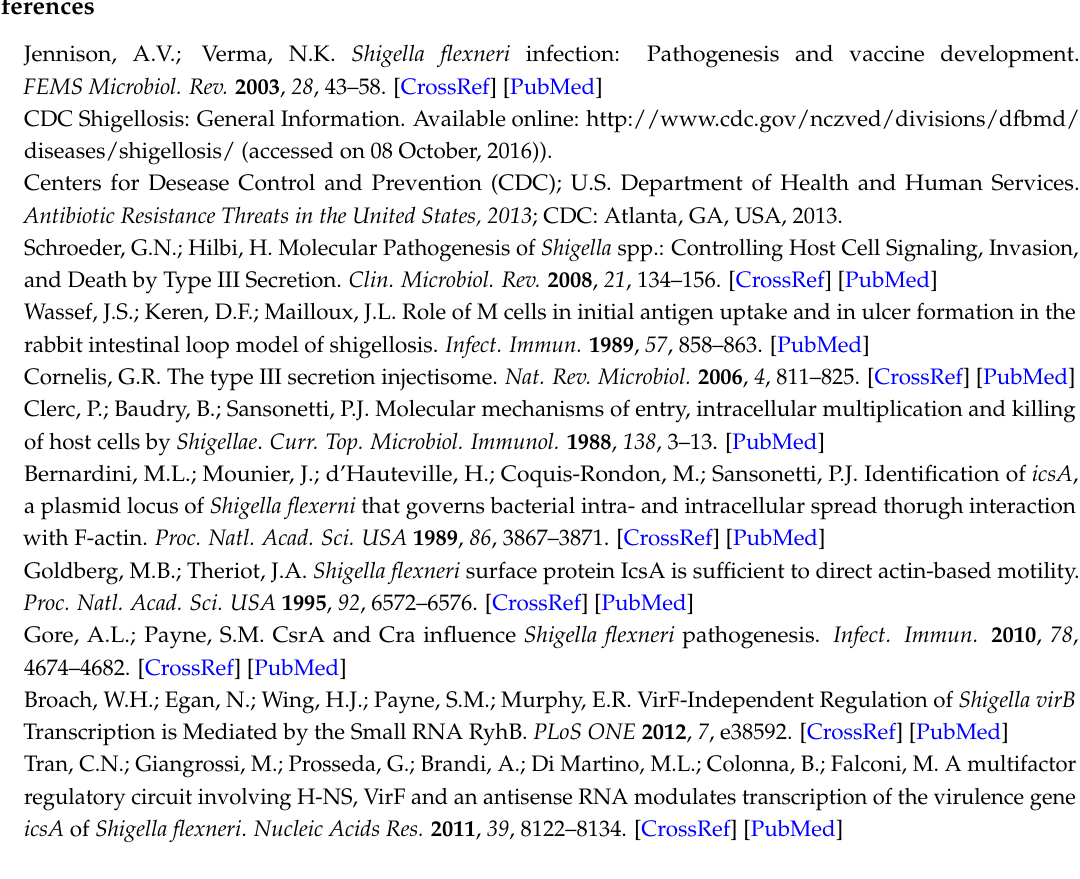
Figure S1: Sequence alignment comparing ryfA across isolates, Figure S2: Pairwise comparison of ryfA across Shigella and Escherichia isolates, Table S1: Primers and Probes Used, Table S2: Strains and Plasmids Used. Acknowledgments: This work was supported by grant R15AI103887 awarded by the National Institutes of Health. We would also like to thank Yahan Wei and Michelle Pate for their technical expertise and useful